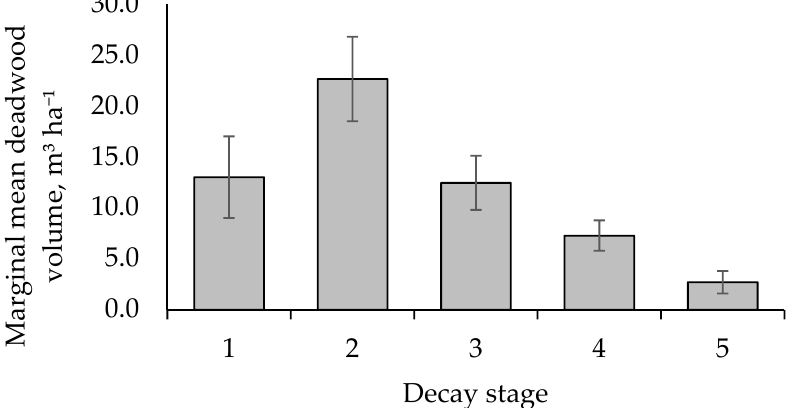
Figure 5. Volume of deadwood ( ± confidence interval) in old-growth stands by decay stage (applied by Mäkinen et al. [43]): (1) recently dead, (2) weakly decayed, (3) moderately decayed, (4) very decayed, and (5) almost completely decomposed.